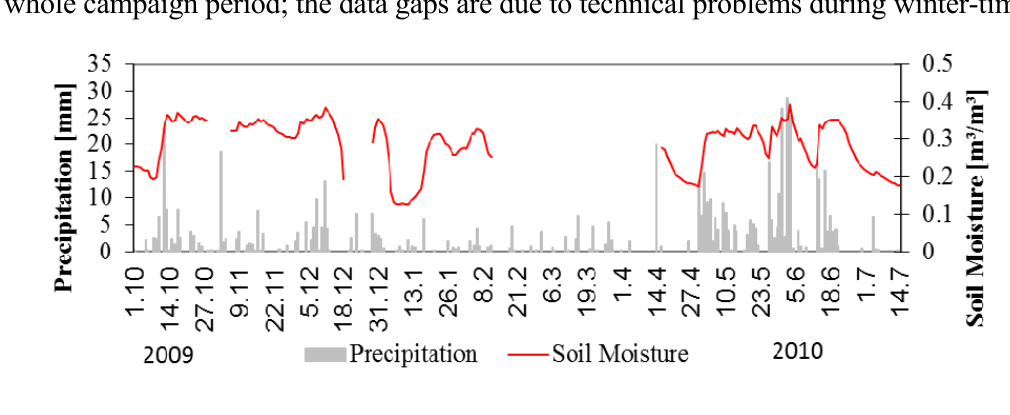
Figure 3. Daily soil moisture measured at a depth of 5 cm and precipitation as daily sum for the whole campaign period; the data gaps are due to technical problems during